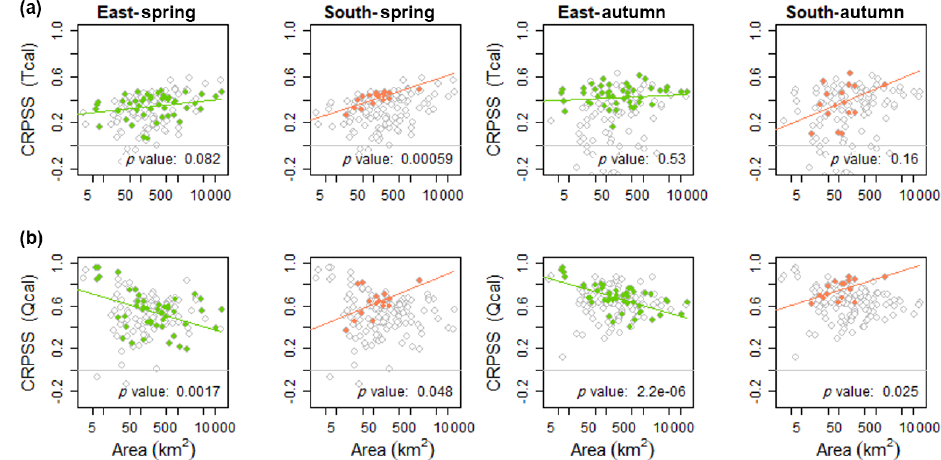
Figure 9. Temperature (row a ) and streamflow (row b ) CRPSS for the east (E) and south (S) regions, plotted as a function of catchment area for both autumn and spring. The colored dots show the CRPSS for the respective regions whereas the grey circles show the CRPSS for all 139 catchments. The linear regression line is plotted along with its p value (significantly different from zero for p values < 0 . 05). All results are presented for a lead time of 5